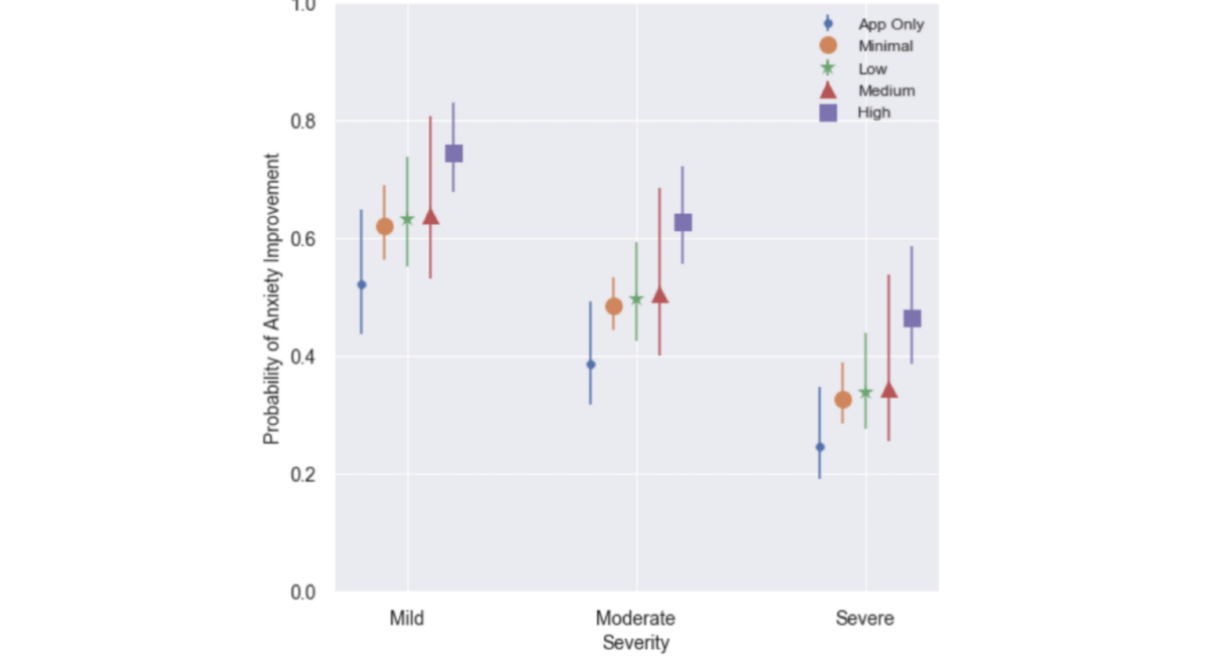
Figure 2. Probability of anxiety improvement by utilization and intake severity among the text-based coaching-only cohort (n=936). Shapes represent the expected mean probability of improvement by modality and intake severity; lines represent the corresponding 95% confidence interval.